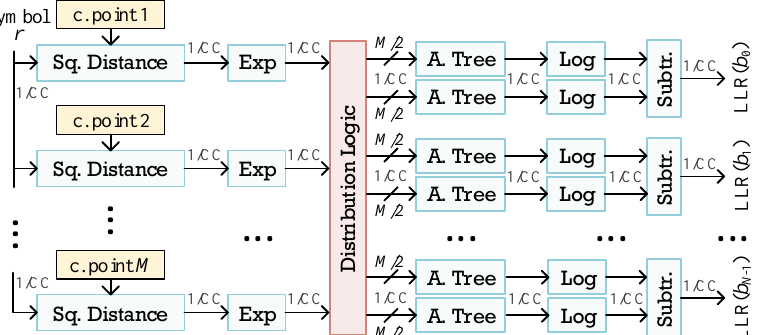
Figure 1. M -QAM demodulation architecture of the exact log likelihood ratio (ELLR)